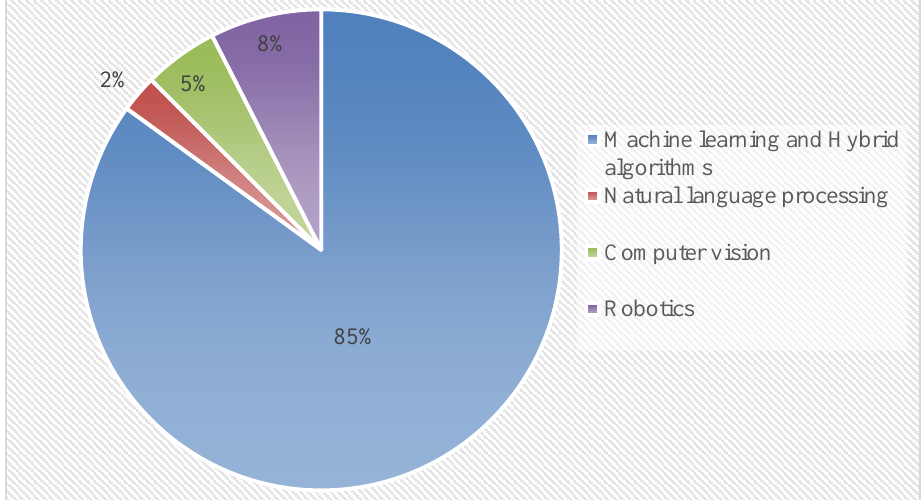
Figure 8. Literature review quantitative analysis for AI technology type